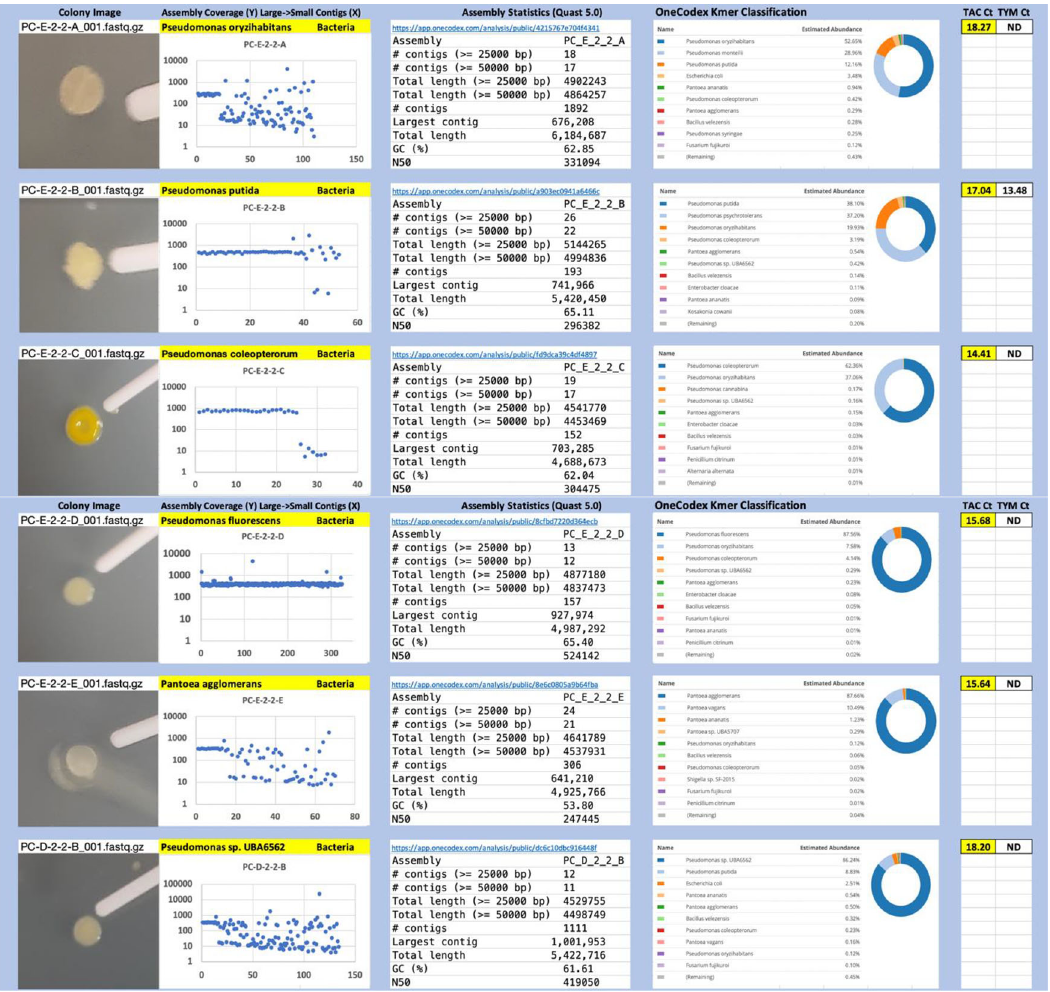
Figure 2. PDA with chloramphenicol. Colony Image (Left), Assembly sequence coverage (Y) compared with contig Length (X) where the contigsare sortedlargest tosmallest from left to right(Mid-Left). Assembly statisticscalculated with Quast 5.0 (Mid Right). OneCodex speciated Kmer count